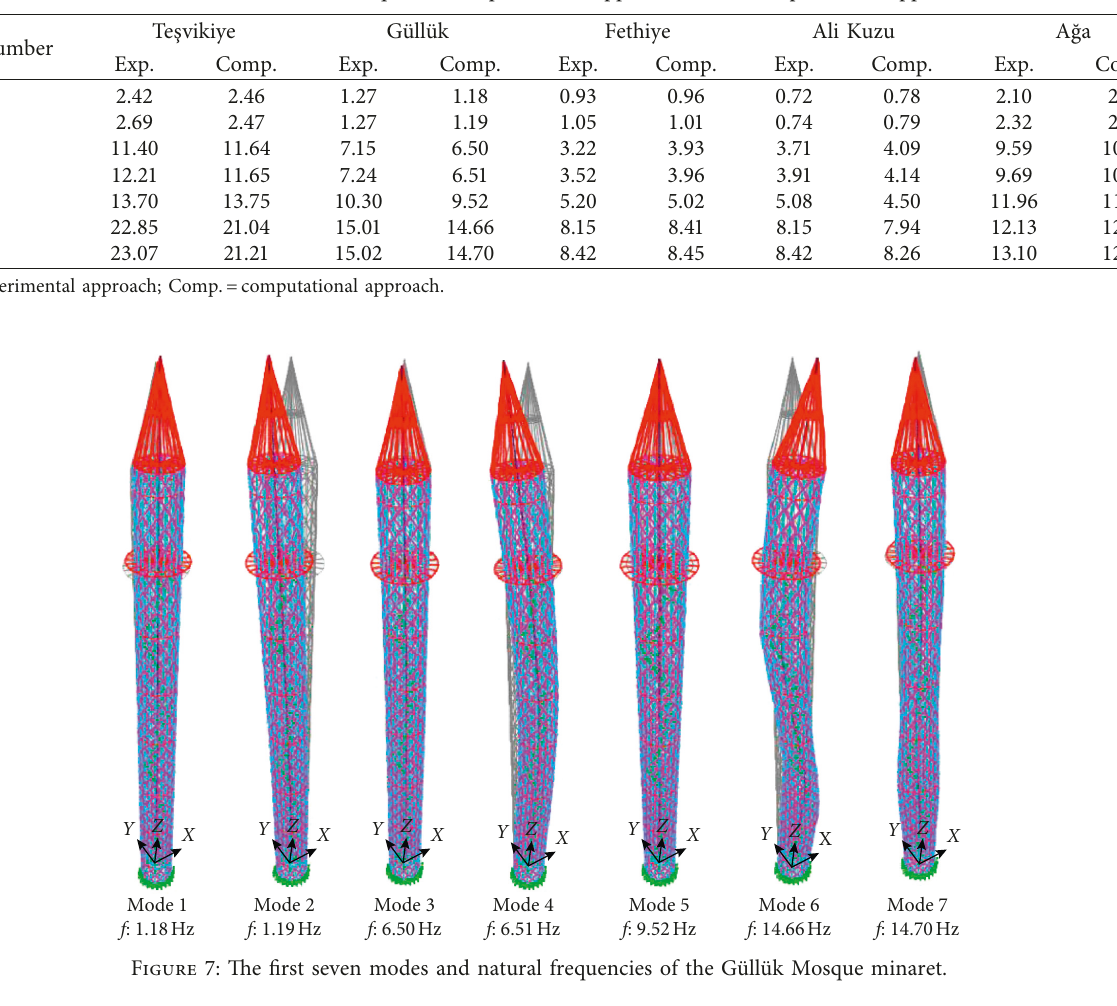
Table 7: First seven modes frequencies (experimental approach versus computational approach).